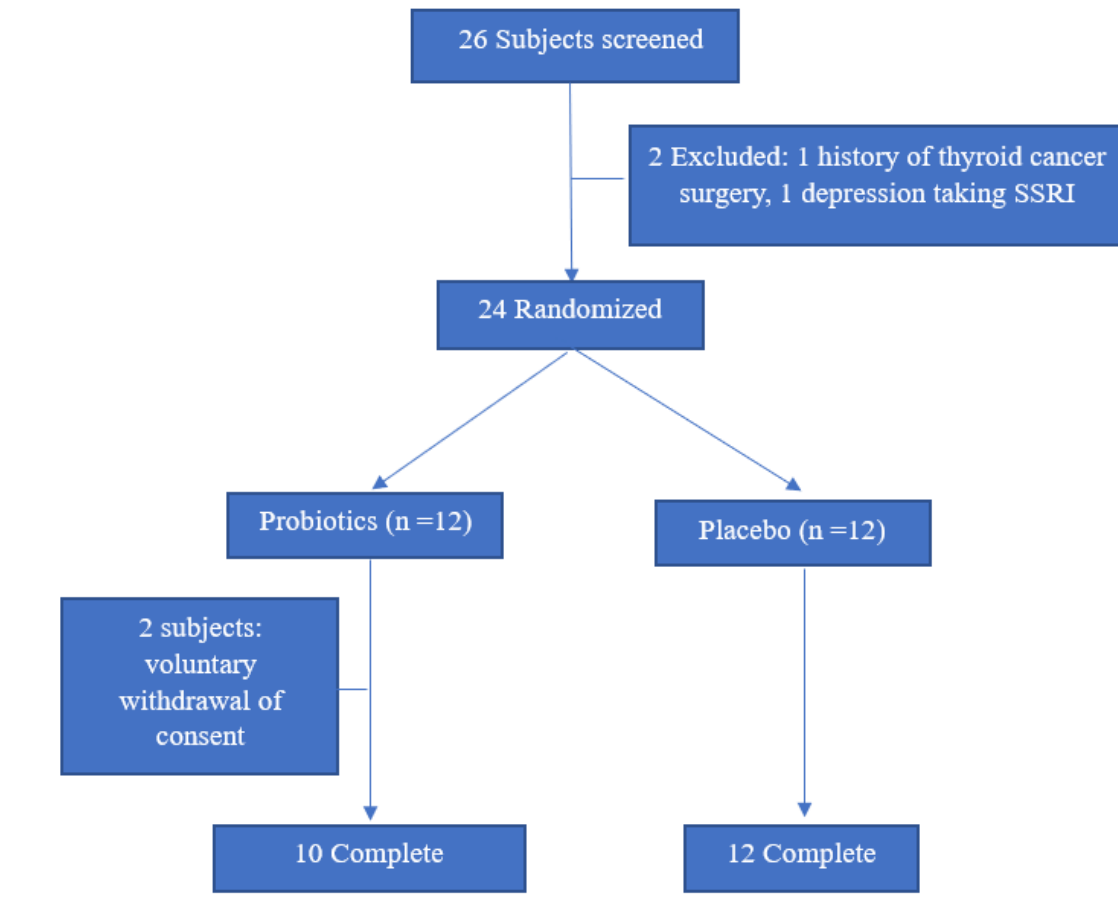
Figure 1. Flow chart outlining the current study protocol.